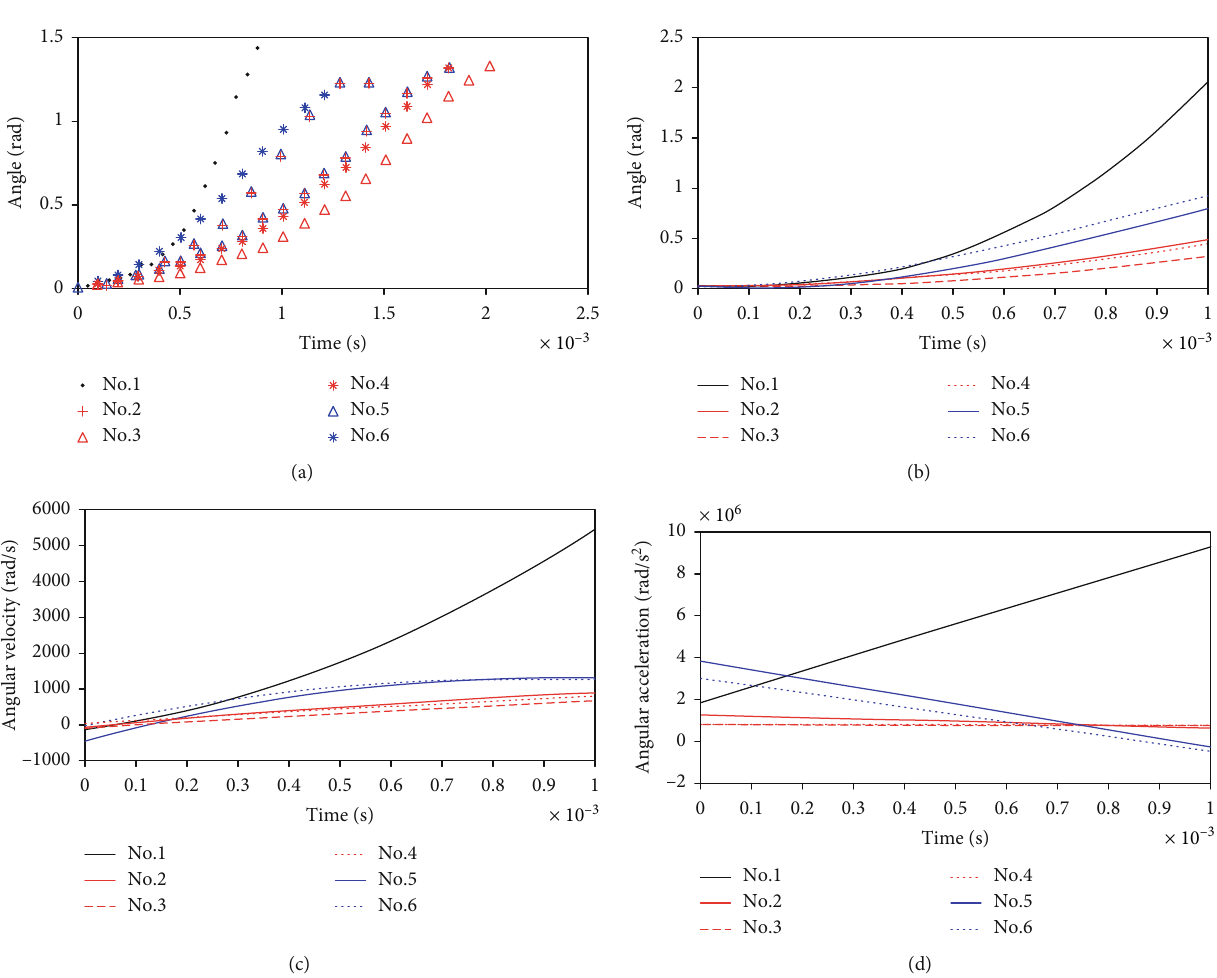
Figure 2: Motion information of the claw. (a) Curve of claw angle and time. (b) Angle of claw as a function of time. (c) Angular velocity of claw as a function of time. (d) Angular acceleration of claw as a function of time. Table 3: Curve fi tting parameters of angle with time.